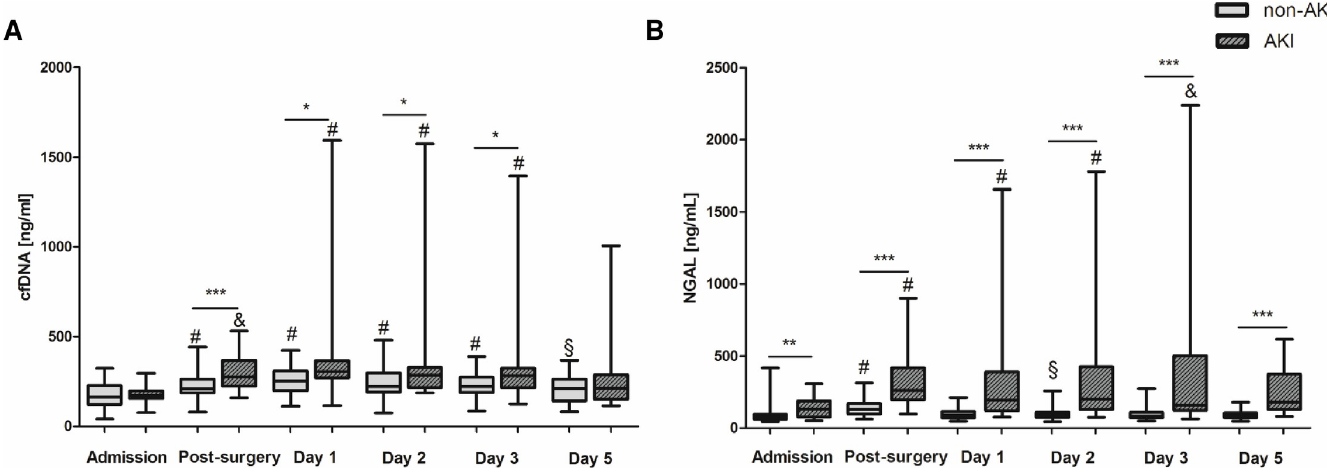
Fig 1. Kinetics of cfDNA/NETs and NGAL in patients undergoing cardiac surgery with CPB. cfDNA (A) and NGAL (B) levels were quantified in plasma of patients with (n = 21,) or without (n = 37) postoperative AKI development at the indicated times. &p < 0.05, §p < 0.01, #p < 0.001 vs. admission; � p < 0.05, �� p < 0.01, ��� p < 0.001.